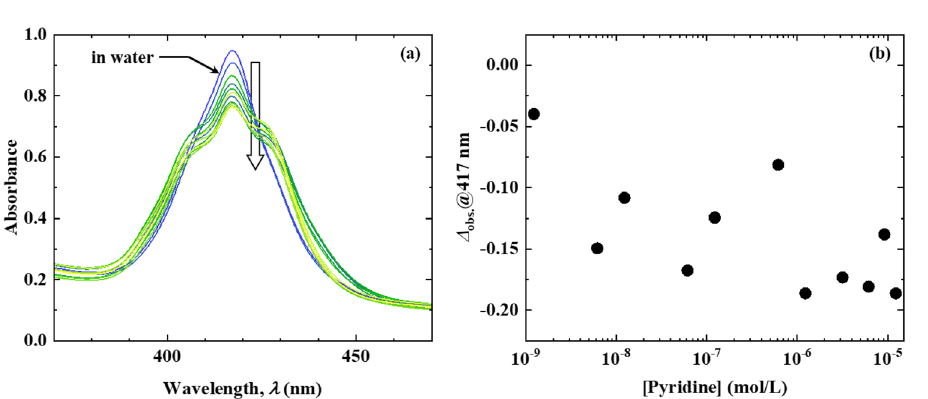
Figure 6. (a) Absorption spectrum of the transparent ZnTPPS/C10S/LDH film after immersion in various solutions of low [Pyridine] ([Pyridine] = 1.23 nmol/L to 12.3 µmol/L). (b) Dependence of Δ A abs. on [Pyridine] at 417